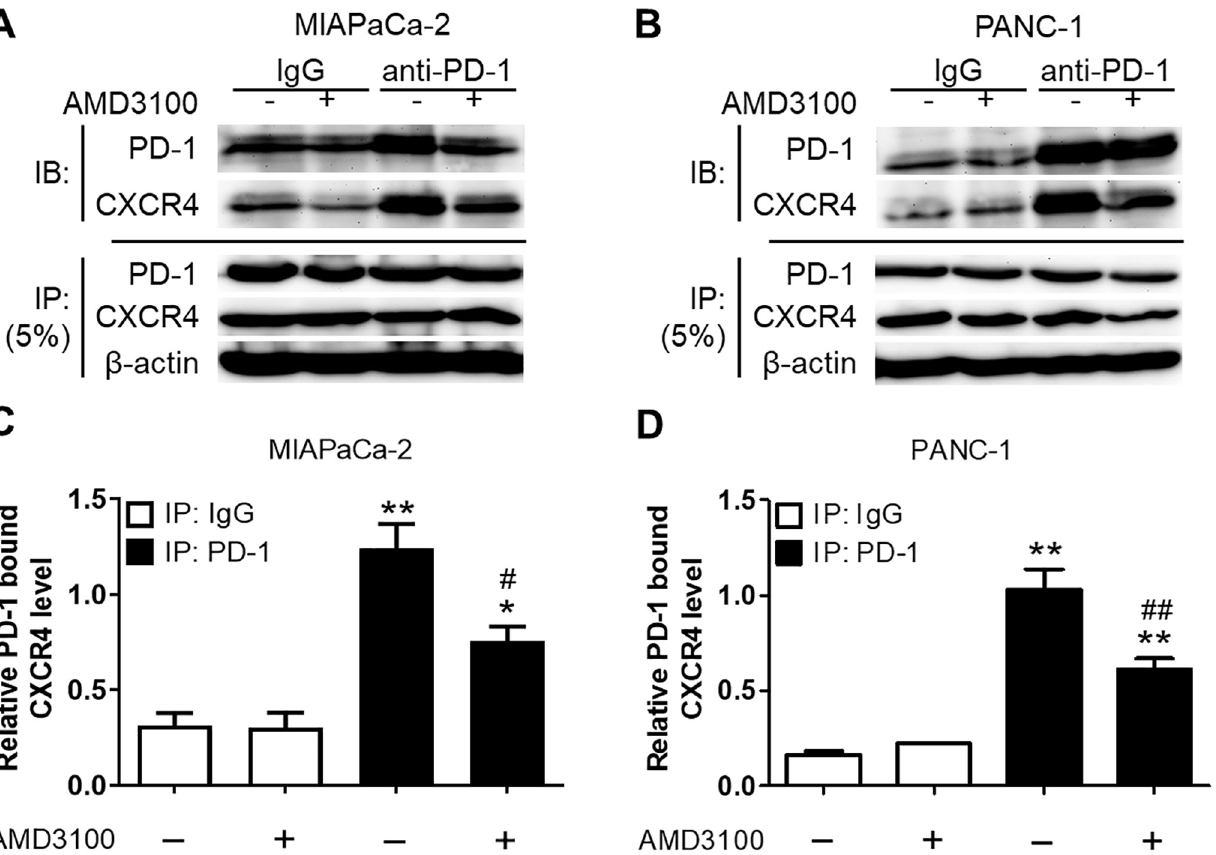
Fig 3. Co-immunoprecipitation studies in MIAPaCa-2 and PANC-1 cell lines. Serum-starved PDAC cells were pre-treated with solvent (-) or AMD3100 (1 μ M) (+) for 45 min. Cell lysates were immunoprecipitated with IgG control or anti-PD-1 antibodies. (A, B) Immunoprecipitates were immunoblotted (IB) with anti-PD-1 and anti-CXCR4 antibodies, revealing successful pull down of PD-1 and resultant co-IP of CXCR4; 5% of IB lysate (lower panel) was used as input control. Treatment with AMD3100 revealed reduced levels of PD-1-bound CXCR4 in PDAC cells. (C, D) Quantification of CXCR4 immunoprecipitated with PD-1 in MIAPaCa-2 ( B ) and PANC-1 ( D ) cells normalized to β -actin as shown in A and C, respectively. � p < 0.05, �� p < 0.01 compared with IgG. # p < 0.05, ## p < 0.01 compared with solvent control.